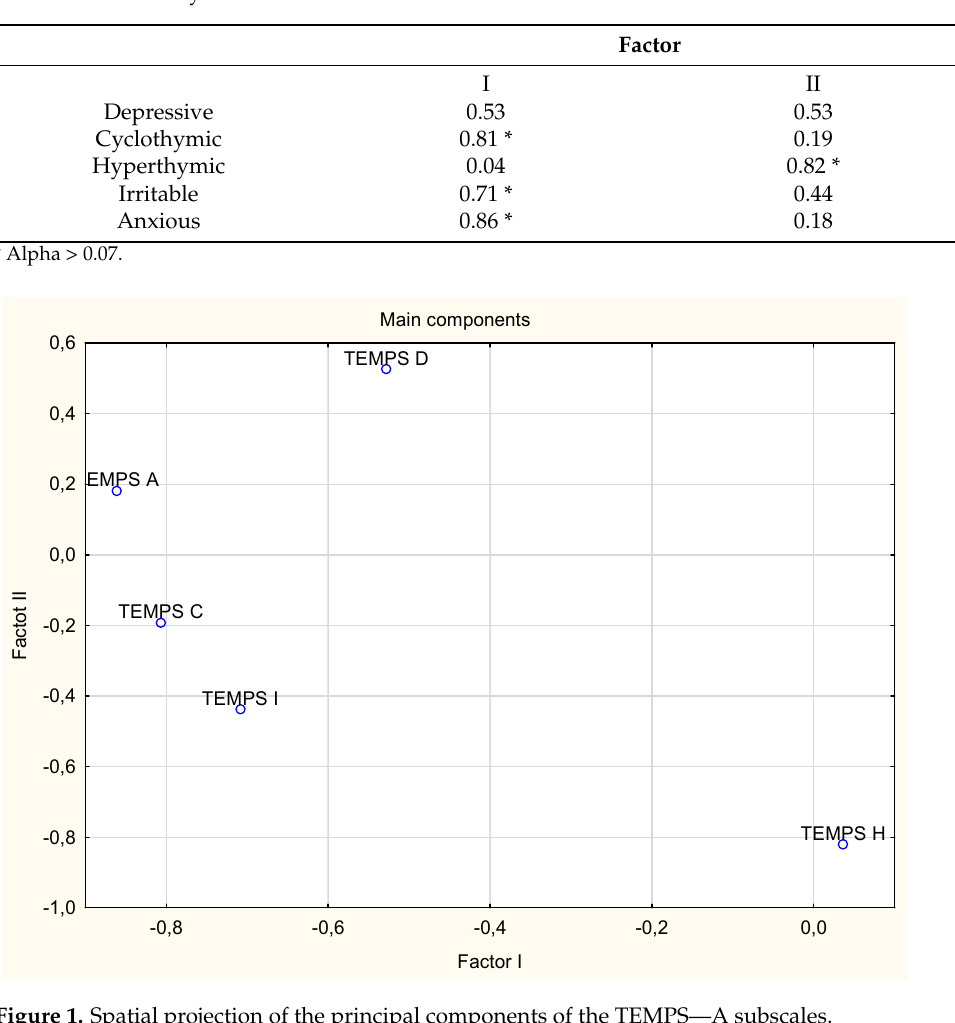
Table 2. Factor analysis of TEMPS—A dimensions.